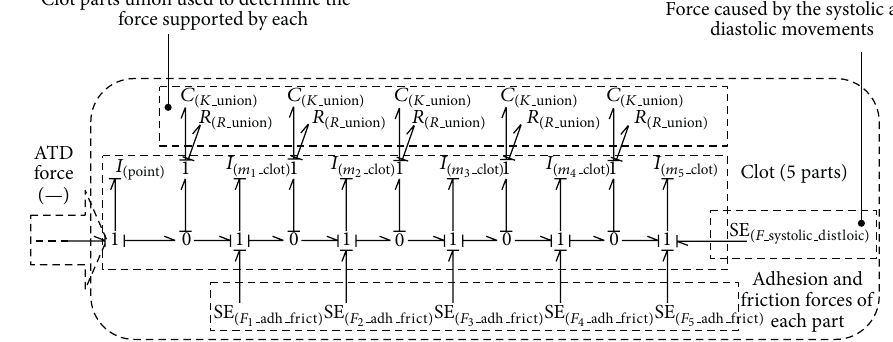
Figure 14: The simplest blood clot model by Bond-Graph technique.